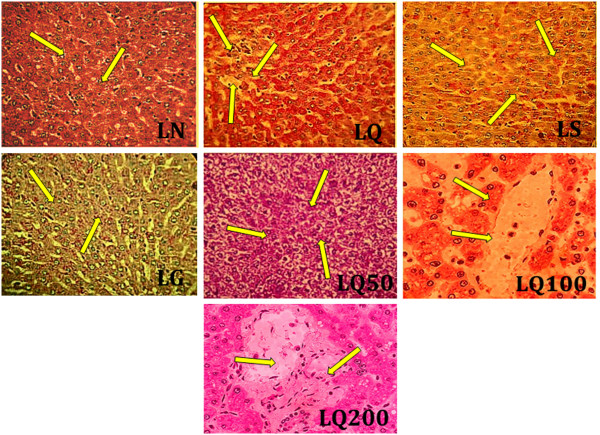
LN = Photomicrograph of section of liver of normal control rat (150x), yellow arrows showing lobular pattern with a centrilobular vein and scorching irregular anastomosing plates of hepatocytes with intervening sinusoids. LQ = Photomicrograph of section of liver of normal control rat received 200 mg/kg p.o of Qurs Tabasheer (150x), yellow arrows showing normal lobular pattern and hepatocytes. LS = Photomicrograph of section of liver of STZ-diabetic rat (150 x) yellow arrow demonstrate accumulation of droplets with distorted morphology of hepatocytes, centrilobular vein and sinusoids. LG = Photomicrograph of section of liver of STZ-diabetic rat (150 x) administered with 1 mg/kg p.o of Glimepiride, yellow arrow portrayed no signs of normal hepatocytes and normal lobular pattern. LQ 50 = Photomicrograph of section of liver of STZ-diabetic rat (150 x) administered with 50 mg/kg p.o of Qurs Tabasheer, yellow arrow exhibits docile hepatocytes and slightly distorted cetrilobular vein. LQ 100 = Photomicrograph of section of liver of STZ-diabetic rat (150 x) administered with 100 mg/kg p.o of Qurs Tabasheer, yellow arrow revealed slightly normal hepatocytes and sinusoids. LQ 200 = Photomicrograph of section of liver of STZ-diabetic rat (150 x) administered with 200 mg/kg p.o of Qurs Tabasheer, yellow arrow divulged the marked improvement in the distorted cetrilobular vein and hapatocytes.